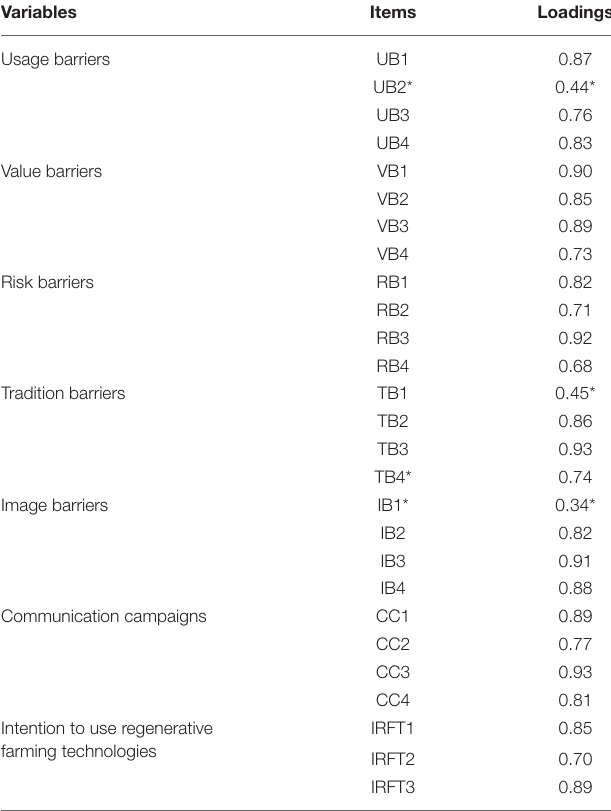
TABLE 2 | Standardized